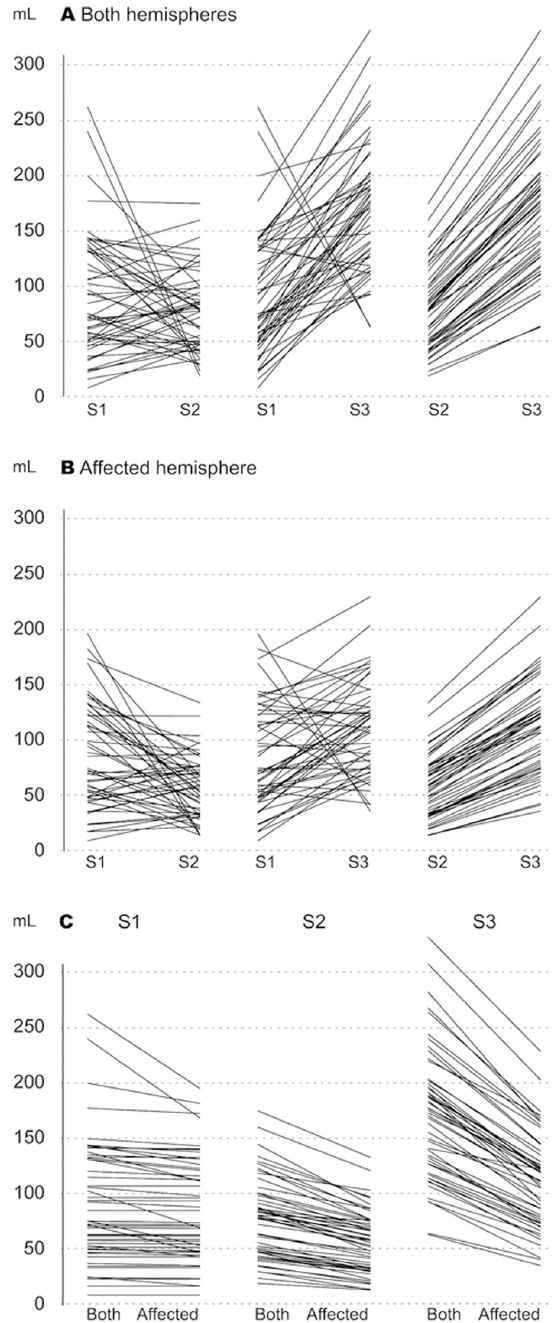
Fig 3. Paired comparisons of the automatically calculated penumbral volumes (mL) for each patient for setting 1 (S1) versus setting 2 (S2), S1 versus setting 3 (S3), and S2 versus S3 using data from both hemispheres (A); S1 versus S2, S1 versus S3, and S2 versus S3 using data from the affected hemisphere only (B); and S1, S2, and S3 using data from the bilateral versus ipsilateral affected hemispheres (C).